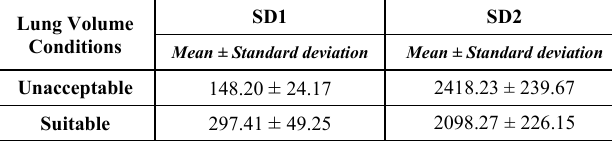
TABLE 5: The average and the standard deviation of the SD 1 and SD 2 parameters with τ = 5.